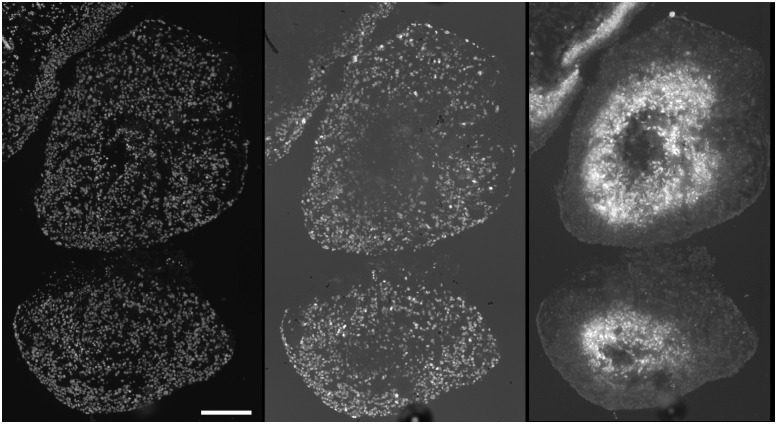
Cell cycling and EF5 binding in SQ20B TF spheroids.Cycling Ki67 positive cells were peripherally localized (central panel), in contrast to the inverse location of EF5 binding cells (right panel). Hoechst 33342 staining of all cell nuclei shown in the left panel. For the larger, more necrotic TF spheroids (small portion seen in upper left of each panel), the EF5 positive cells lined the inside of the viable rim, since EF5 is only metabolized by viable cells (scale bar 250 μm). Ki67 positive cells were also found peripherally in U87 spheroids of all types, but no EF5 binding was observed (data not shown).